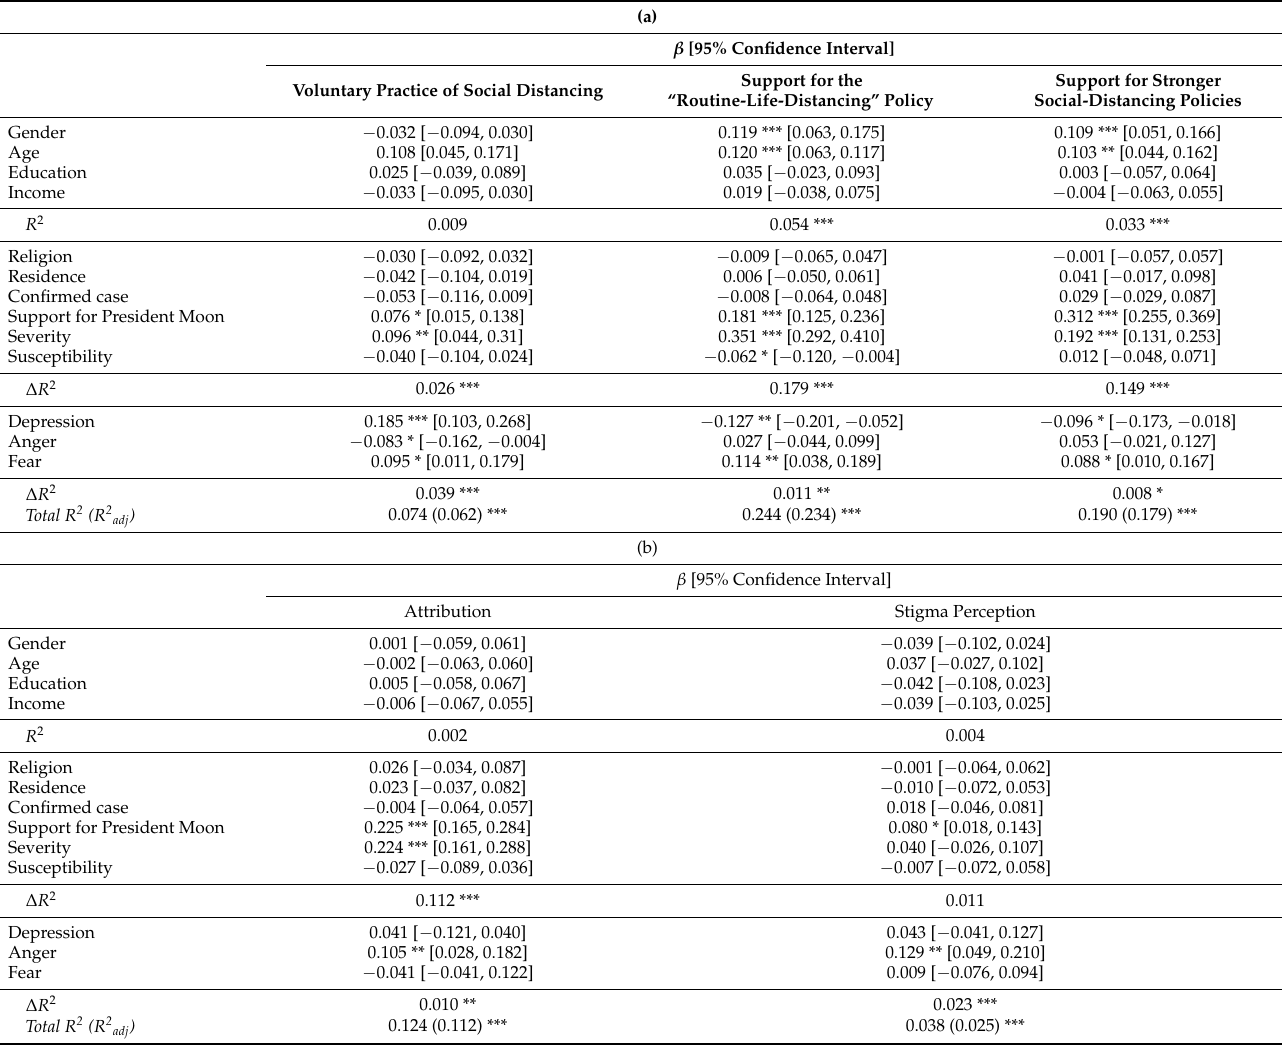
Table 3. ( a ) The results of the regression analysis ( n = 1000) (DV: Compliance with the social-distancing policy); ( b ) The results of the regression analysis ( n = 1000) (DV: Stigmatization). (a) β [95% Confidence Interval] Support for the Support for Stronger “Routine-Life-Distancing” Policy Social-Distancing